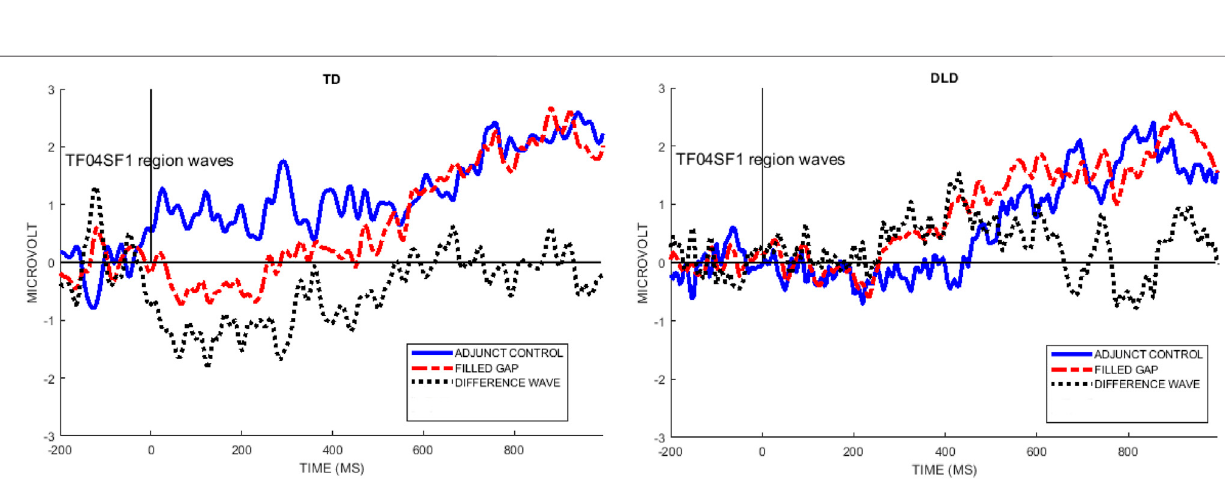
FIGURE 9 | EAN (voltage-ERP); mean voltage waveforms for the EAN-region by group.